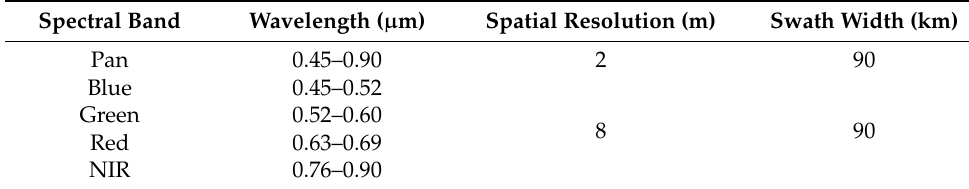
Table 1. Parameters of the 2 m panchromatic/8 m multispectral cameras.